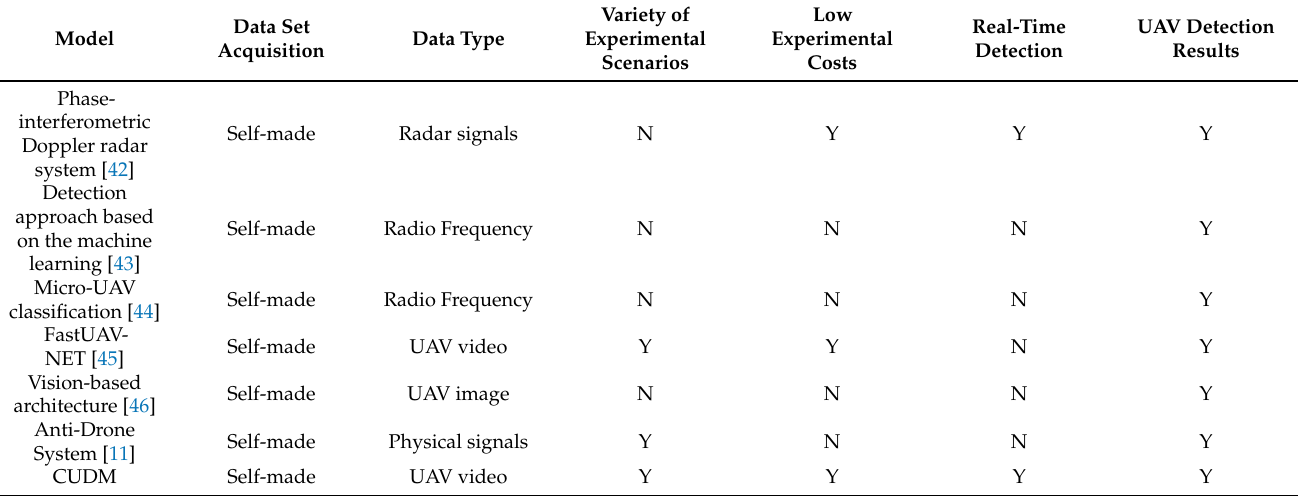
Table 3. Comparison of CUDM and other UAV inspection systems.